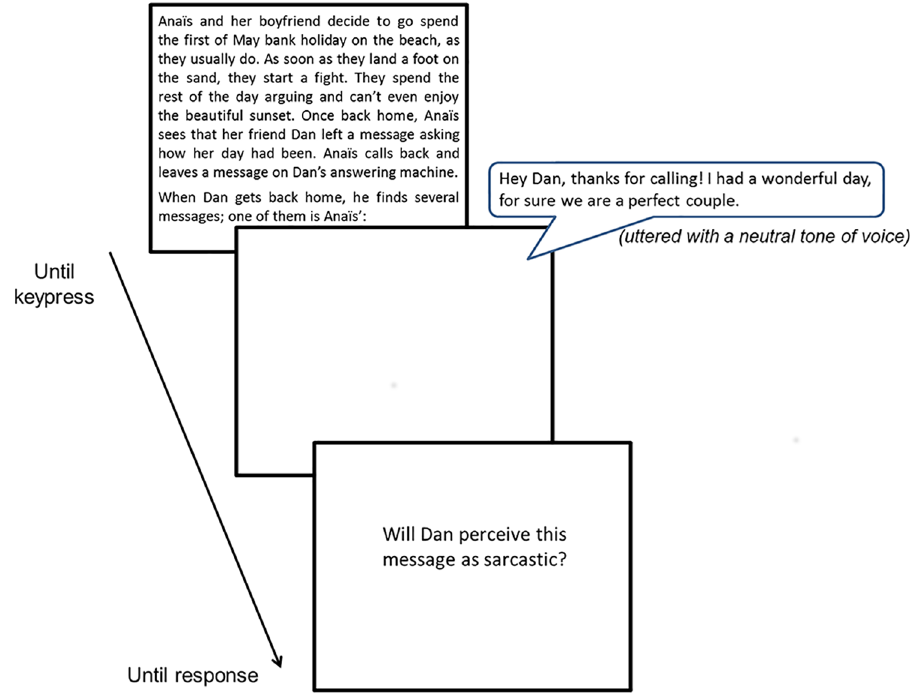
Fig 2. Sarcasm Detection Task: the course of a trial. All trials start with the written presentation, on the computer screen, of an event in the character Ana ï s Reton ’ s life; the text remains on screen until the participant presses a key signalling that he finished reading the story. Voicemail messages are then auditorily delivered and directly followed by the question “ Will he (or she) perceive this message as sarcastic? ” . (Correct answer for this example is No ). The next trial began once the participant had answered the question by pressing the corresponding